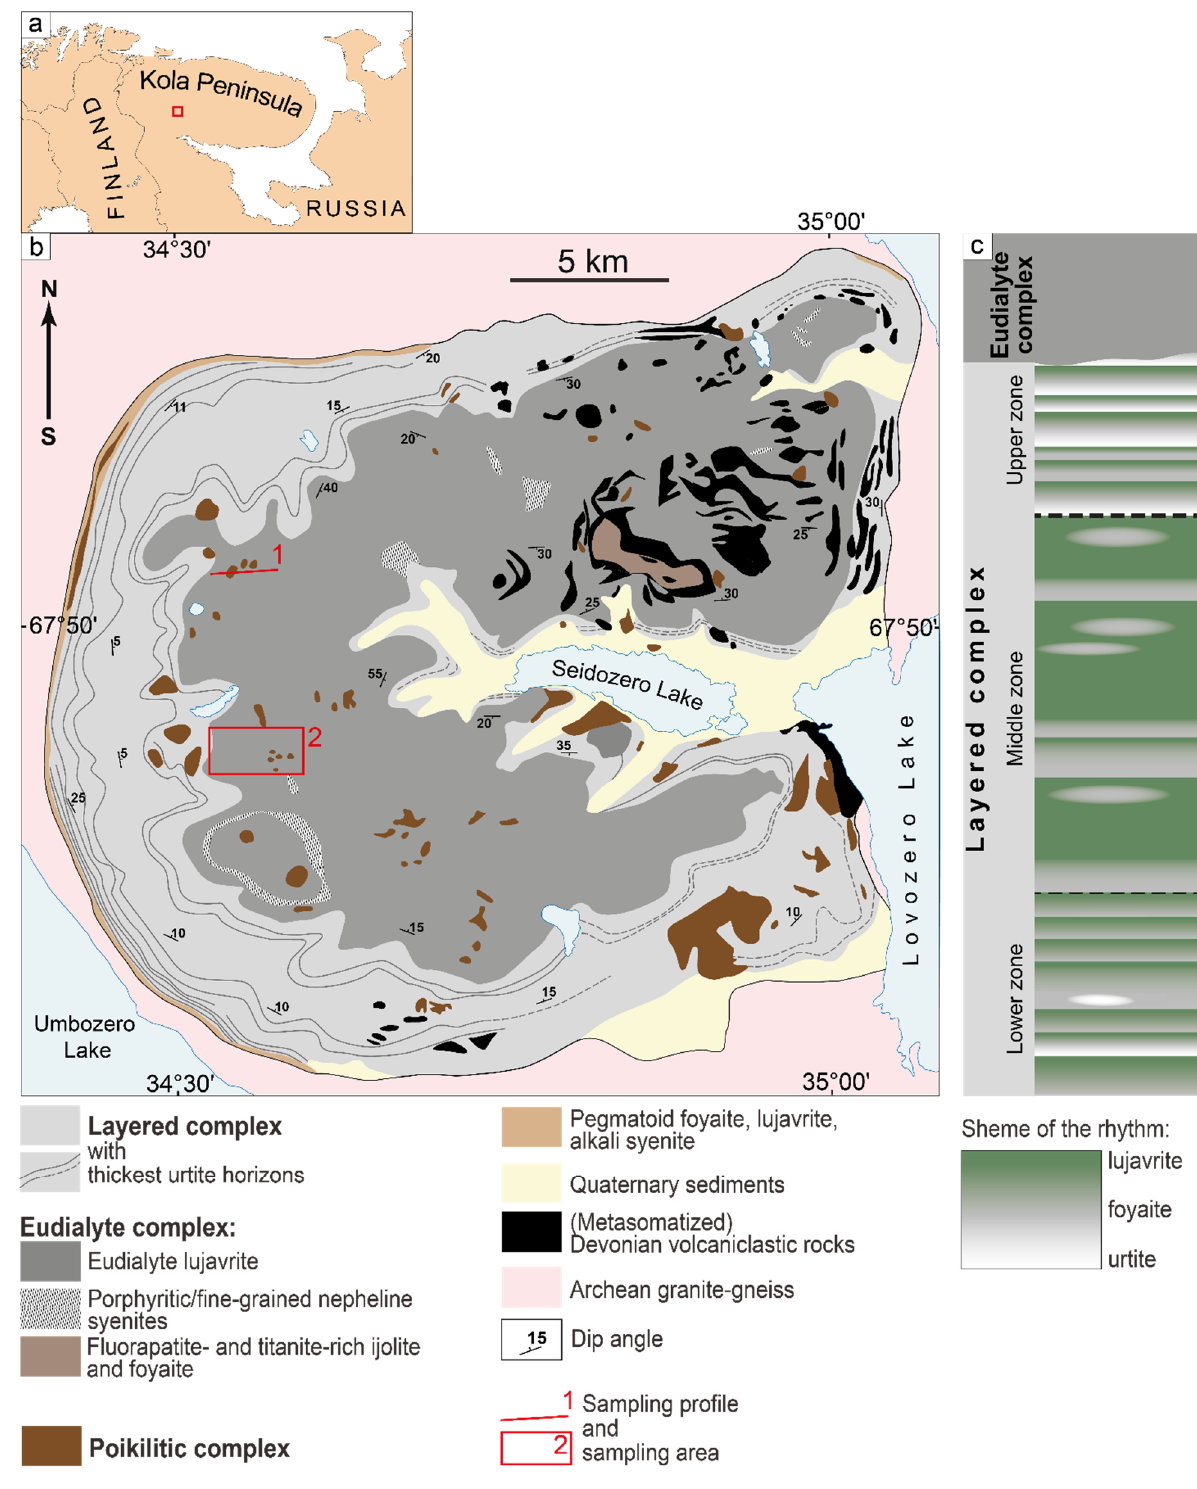
Figure 1. ( a ) Location of the Lovozero massif within the Kola Peninsula (red square); ( b ) geological scheme of the Lovozero massif (adapted from [29]); and ( c ) schematic cross-section of the Eudialyte and Layered complexes. The Eudialyte complex is located in the upper part of the Lovozero massif (Figure 1b,c) and occupies 18% of its volume [30]. The thickness of this complex is from 100 (in the east) to 800 m (in the north-west). The main rock of the Eudialyte complex is lujavrite enriched in eudialyte-group minerals (EGM), the so-called eudialyte lujavrite. Among